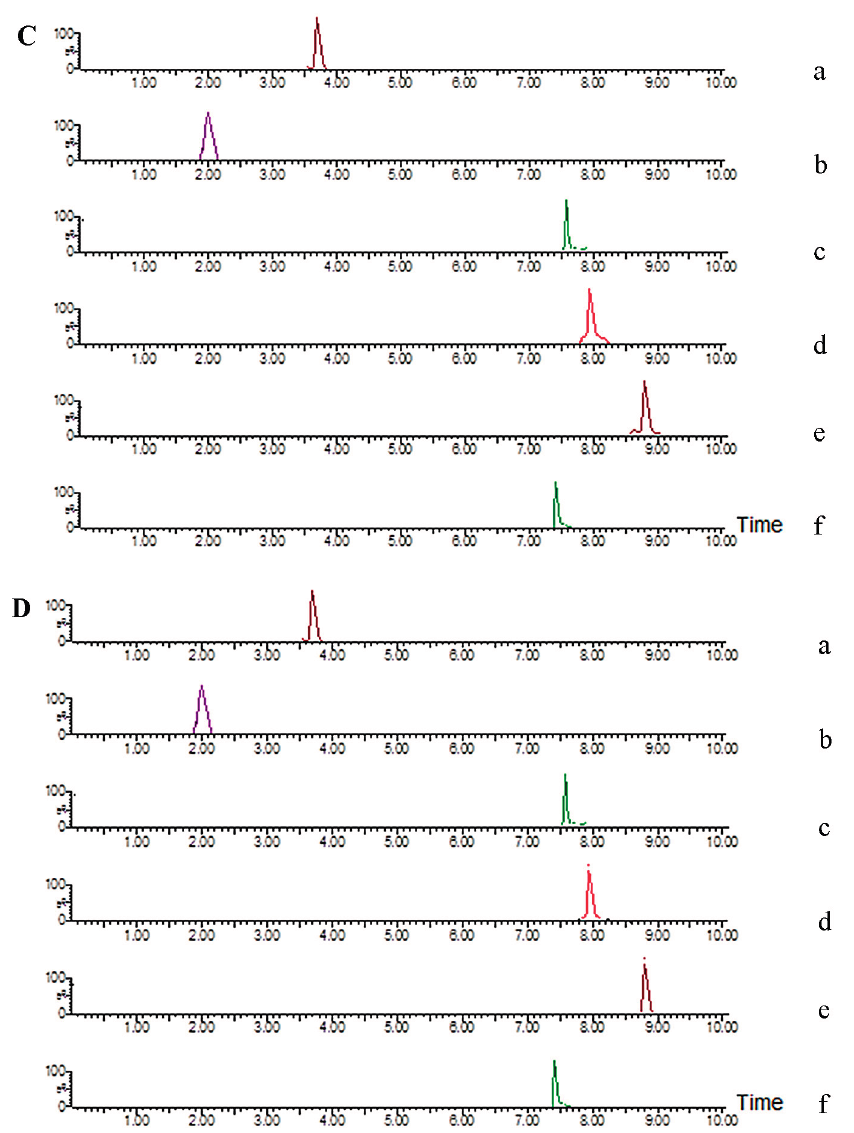
Figure 2. MRM chromatograms of each compound ( a . mangiferin; b . neomangiferin; c . timosaponin BII; d . anemarsaponin BIII; e . timosaponin AIII; f . chloramphenicol). ( A ) blank plasma; ( B ) blank plasma spiked with each compound at LLOQ; ( C ) plasma sample at 45 min after oral BZT; ( D ) plasma sample at 45 min after oral